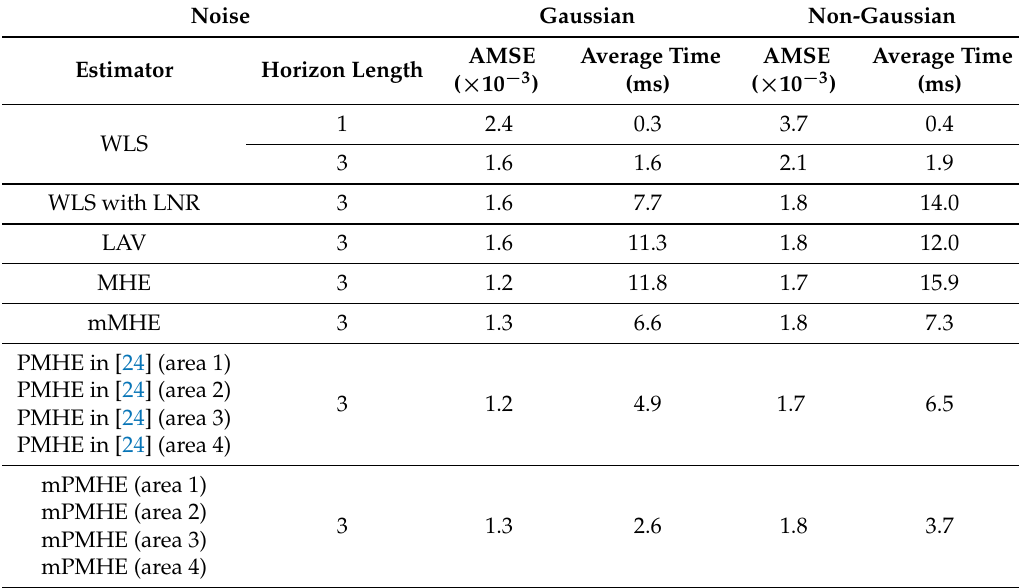
Table 2. The Average of Mean Square Error (AMSE) and average computation time (per step) with different estimators in the IEEE 14-bus system with redundant